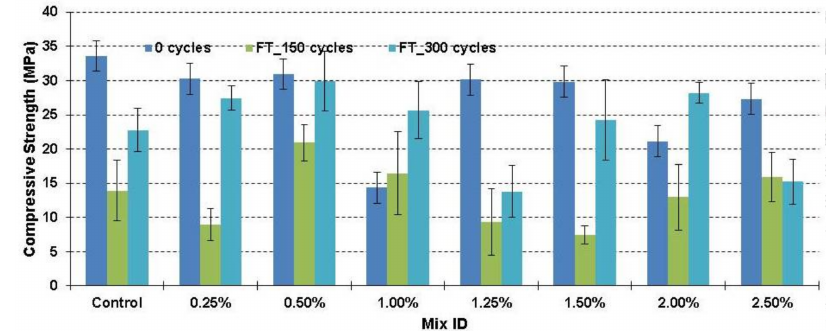
Figure 6. Compressive Strength Results due to Freeze and Thaw Cycles.